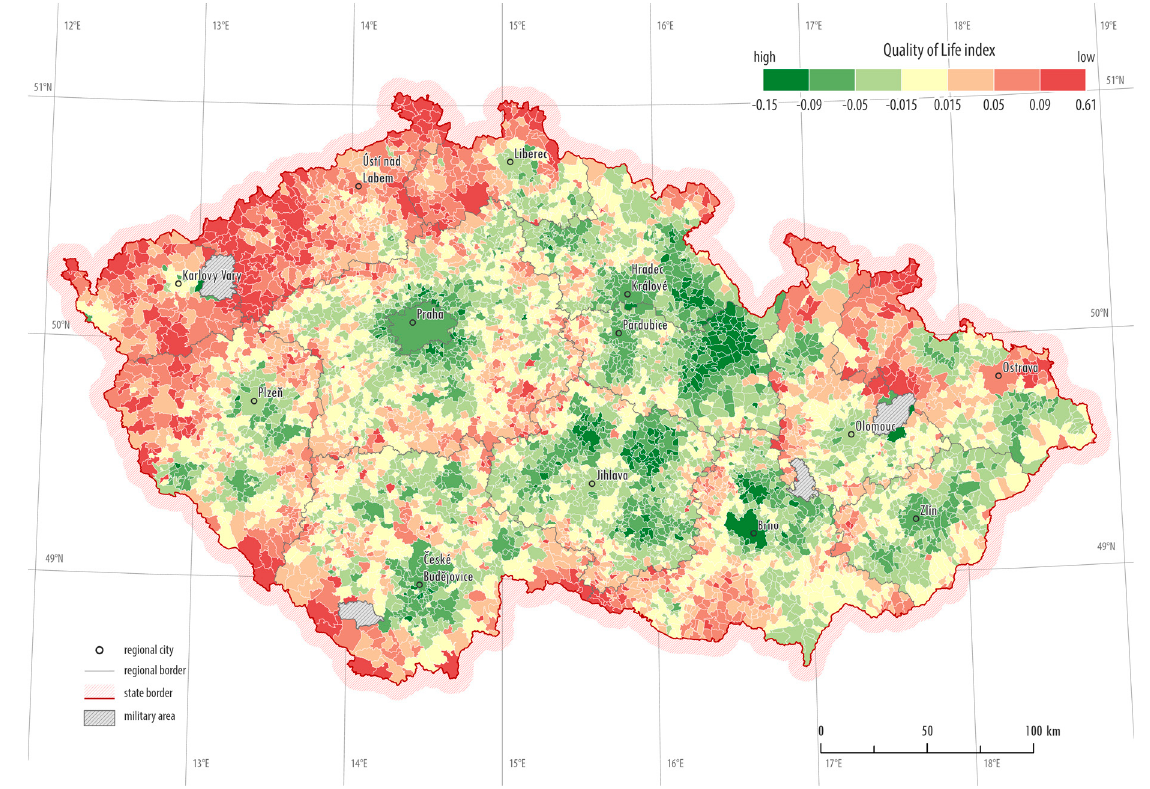
Figure 2. Adjusted index with accessibility indicators based on network